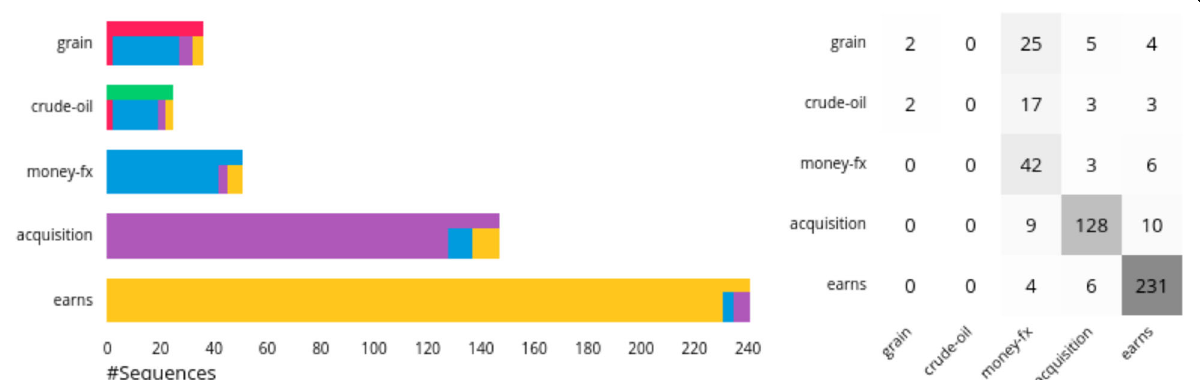
Fig. 6 Classification result in the form of stacked bar charts (left) and a confusion matrix (right). The visualizations show that there are many more sequences available for the classes earns and acquisition compared to the others. In addition, it is clear that sequences of the classes earns , acquisition , and money-fx were well classified, whereas the model had problems with grain and crude-oil . Underlying data source: Reuters [25]